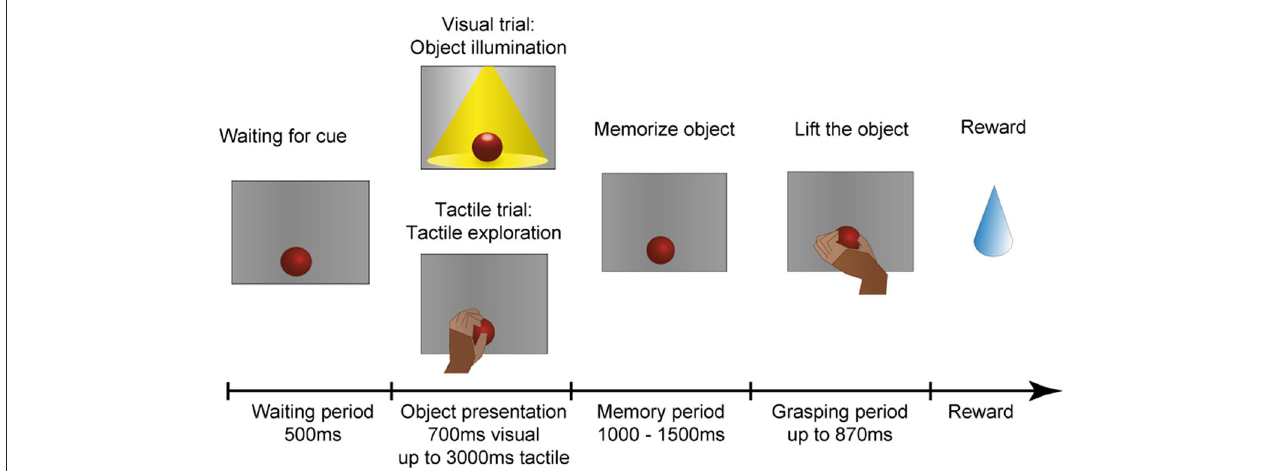
FIGURE 7 | Task paradigm. After an object has arrived in front of the animal, it has to wait in the dark for an object presentation period, in which the animal could identify the object either visually or tactually. In the visual task, the object is illuminated for 700 ms. In the tactile task, however, the monkey remains in the dark and instead has to reach out, touch and briefly lift the object (maximal duration: 3,000 ms). The animal is then required to memorize the object for 1,000–1,500 ms before instructed to lift the object within 870 ms. All successful trials are rewarded with a fluid reward.